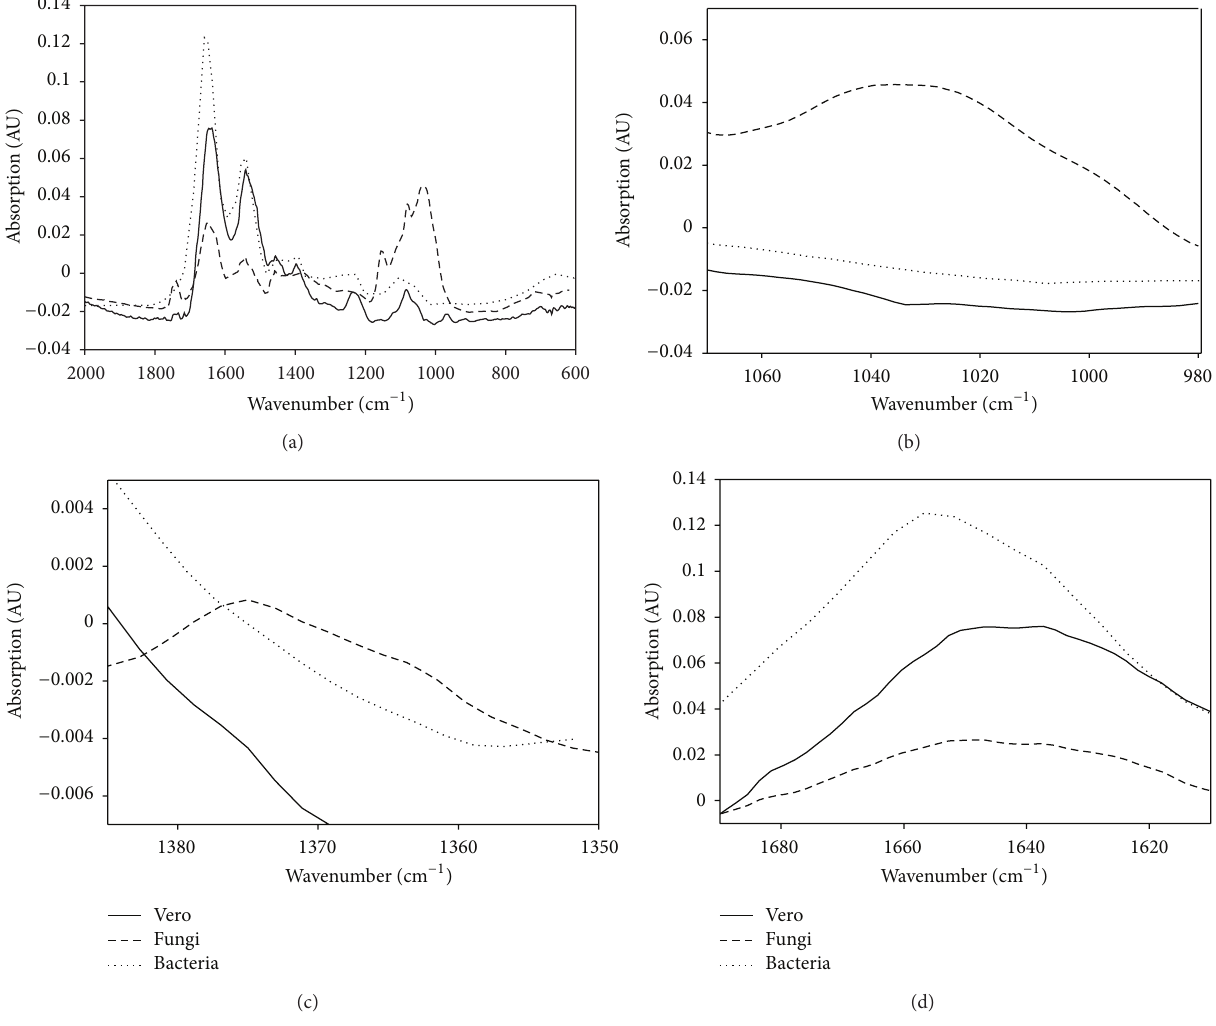
Figure1: FTIRspectraof controlVero cells, pure E. coli bacteria, andpure Candida albicans fungi atthefollowing regions: (a)600–2000 cm −1 , (b) 1070–980 cm −1 , (c) 1390–1350 cm −1 , and (d) 1690–1610 cm −1 . Data are means of 10 different and separate experiments for each